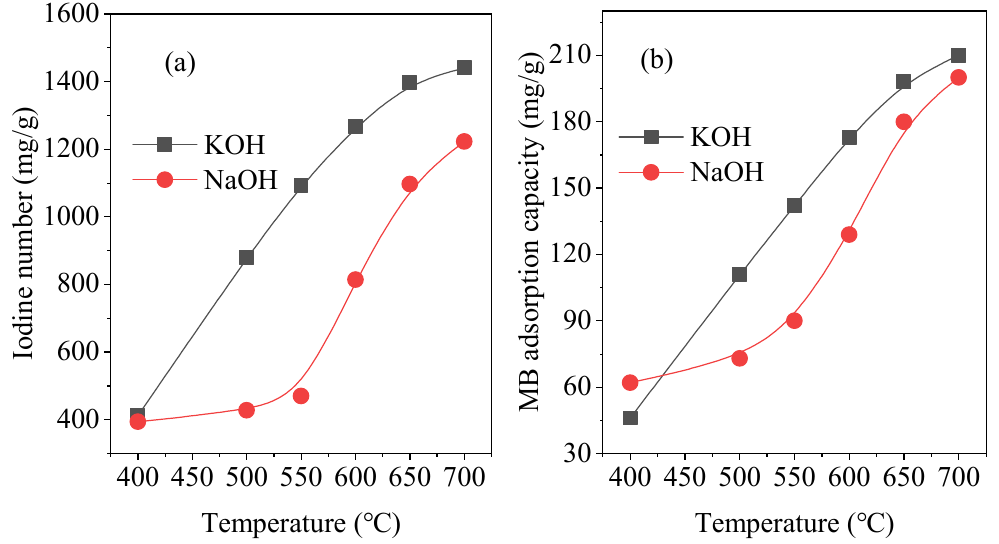
Figure 4. Effect of activation temperature on the adsorption performance of activated carbon: ( a ) iodine number, and ( b ) MB adsorption capacity. Conditions: alkali carbon ratio 1.5:1 and impregnation time 48 h.